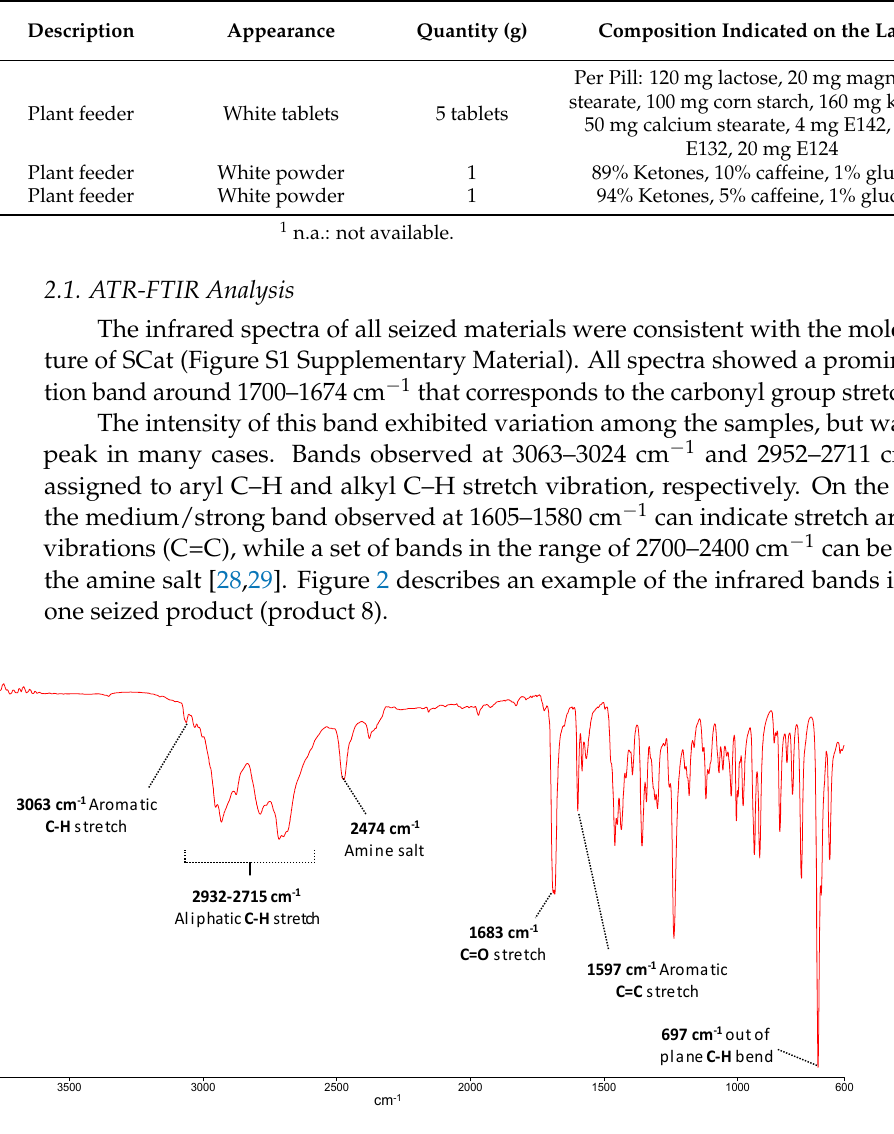
Figure 2. FTIR spectrum of product 8 (“Charlie”).